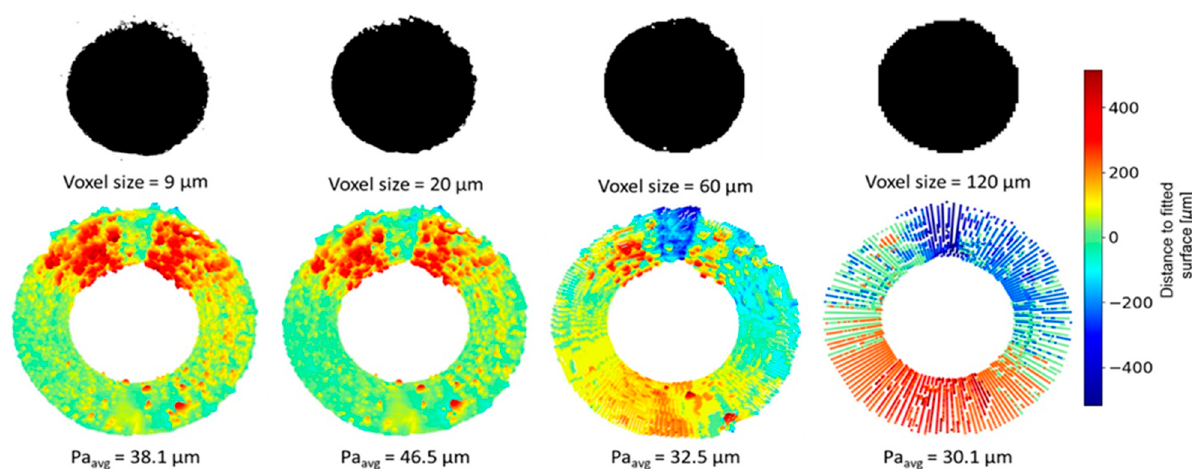
Figure 3. Investigation of the effect of voxel size on qualitative and quantitative evaluation of surface texture. The shown case is for D nom = 6 mm (sample A). The top row of images shows the quality of cross-sections at different voxel sizes. The bottom row shows 3D color plots of the investigated channel at different voxel